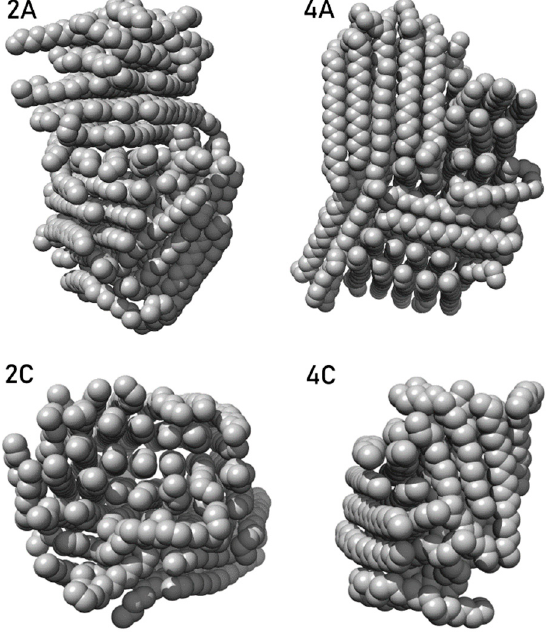
Figure 2. Hydrophobic cores of typical dendron clusters of L2 – 12 ( left ) and L2 – 15b ( right ) depicted in Figure 1 (Lines 2 and 4). The labeling refers to structures in Figure 1. Only carbon atoms of aliphatic chains are shown for better clarity.